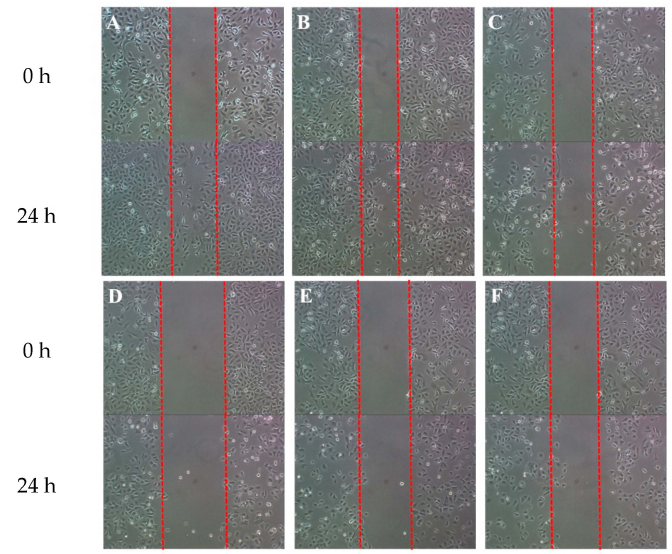
Figure 7. Wound healing assay of A549 cells treated with ( A ) DMSO, control group; ( B ) SNL 25 µ g/mL; ( C ) SNL 50 µ g/mL; ( D ) SNL 75 µ g/mL; ( E ) HA/SNL aggregates 25; and ( F ) HA/SNL aggregates 50.